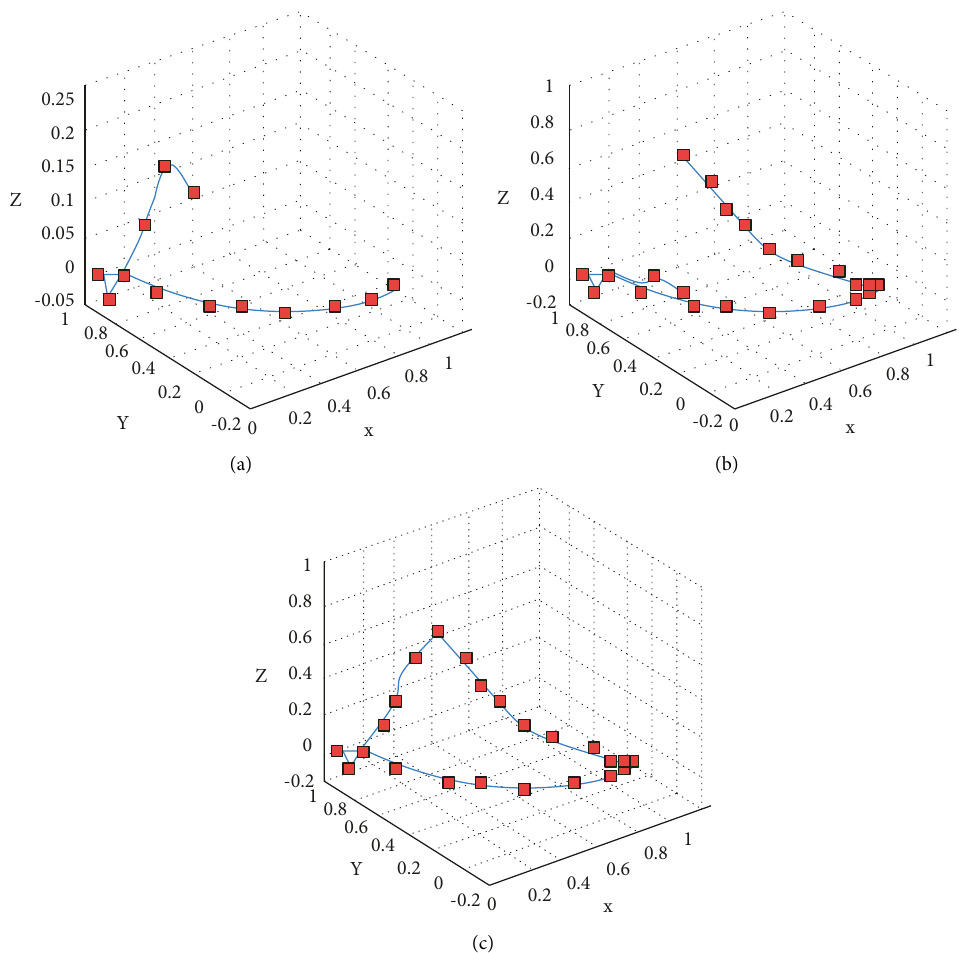
Figure 6: Competitive relationship trajectory of A ((a) 20 iterations; (b) 40 iterations; (c) 100 iterations).